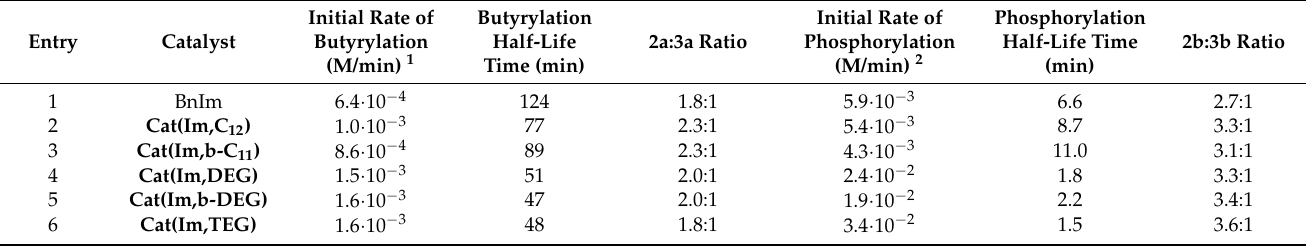
Table 3. Butyrylation and phosphorylation of substrate 1 , promoted by the catalysts of the Im family, as depicted in Scheme 3.